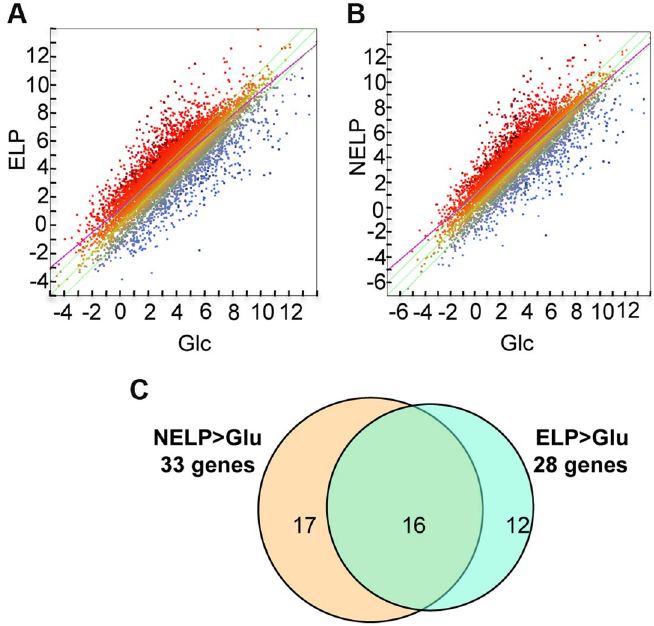
Figure 5. P.gigantea transcriptome. Scatterplots show the distribution of RNA-seq RPKM values (log 2 ) for 11,376 P. gigantea genes when grown on basal salts containing A, acetone-extracted loblolly pine wood (ELP) or B, non-extracted loblolly pine wood (NELP) relative to glucose (Glc). Plot lines define 2-fold borders and best fit regression. Darkened points represent 164 (A) and 145 (B) transcripts accumulating . 4-fold at p , 0.01. Venn diagram (C) illustrates genes with RPKM signals . 10 and upregulated . 4-fold in NELP or ELP relative to Glc.